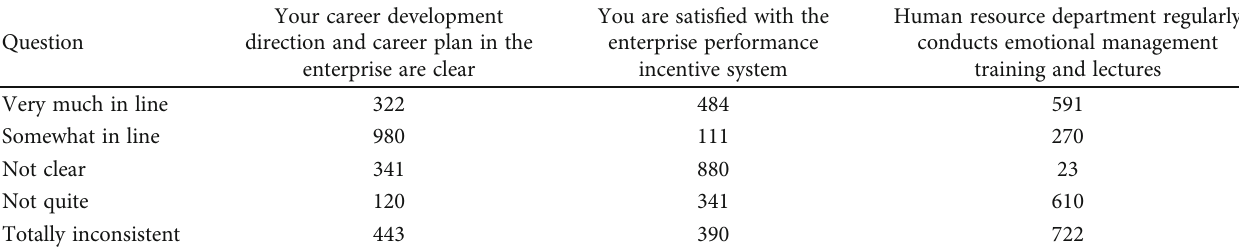
Table 4: Question setting and evaluation of human resource management and development.